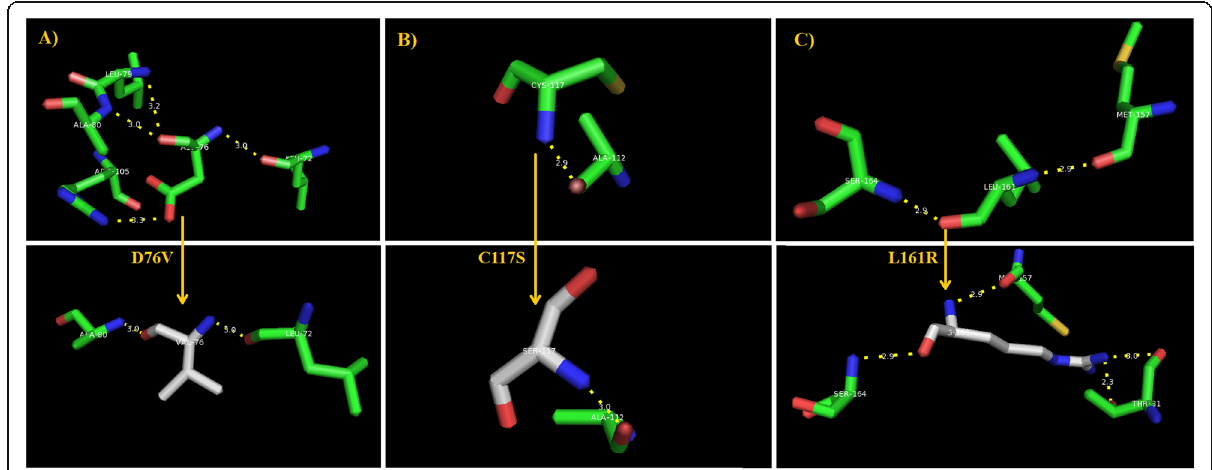
Fig. 5 Polar interactions of 3D structures of leptin before mutation and after its being mutated with D76V, C117S, and L161R, in a ), b ), and c ), respectively. Noticeable alterations in the binding capacity between leptin wild-type residue and both D76V and L161R mutants ’ residues are found. The C117S mutant residue showed the same binding capacity compared with the wild type residue and the only alteration is found in the distances of this binding. Figures are generated by the measurement tool of PyMol